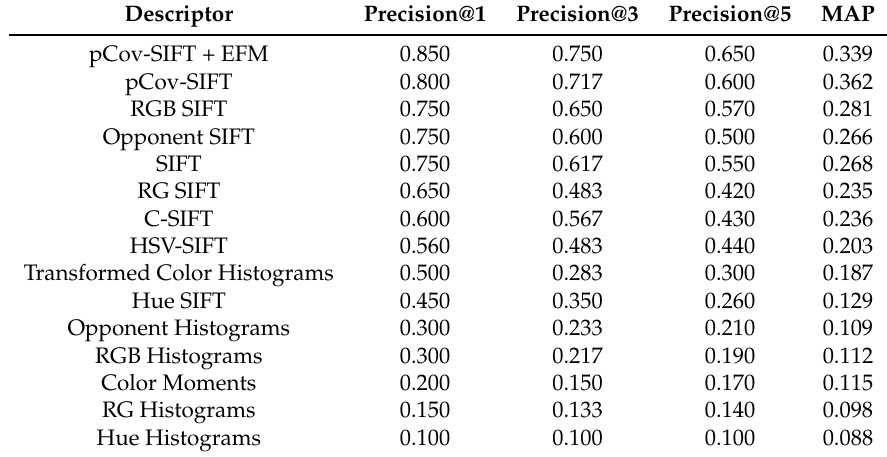
Table 1. Comparison between different descriptors employed in our evaluation. pCov-SIFT is the projected covariance descriptor (see Section 4) and pCov-SIFT + EFM (Explicit Feature Map) is the projected covariance descriptor using the explicit feature map (see Section